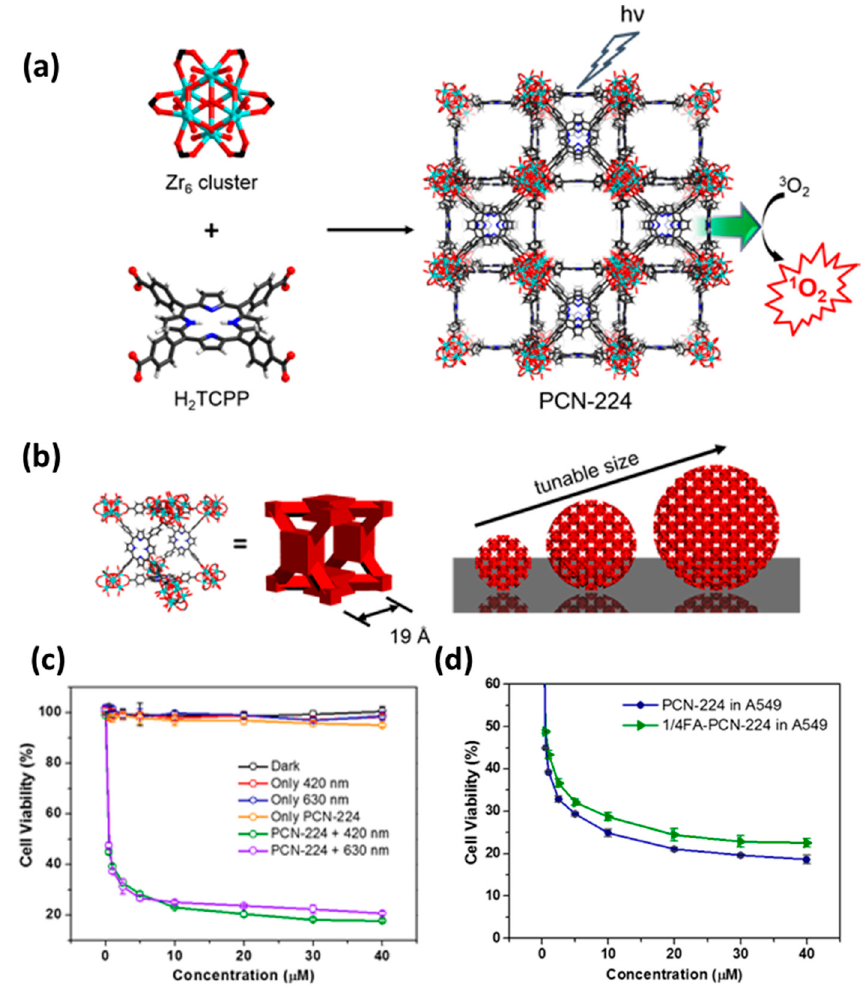
Figure 9. Schematic diagram of PCN–224 structure. ( a ) The 3D nanoporous structure of Zr 6 metal cluster, H 2 TCPP ligand and PCN–224. ( b ) The PCN–224 cube element, with its composition of spherical nanoparticles of different sizes. ( c ) Comparison of killing effect of 90 nm–PCN–224 on HeLa cells under different laser conditions. ( d ) Comparison of photodynamic therapy effect of PCN–224 and 1/4 FA–PCN–224 in vitro. Reproduced with permission from Ref. [96]. Copyright 2016, American Chemical